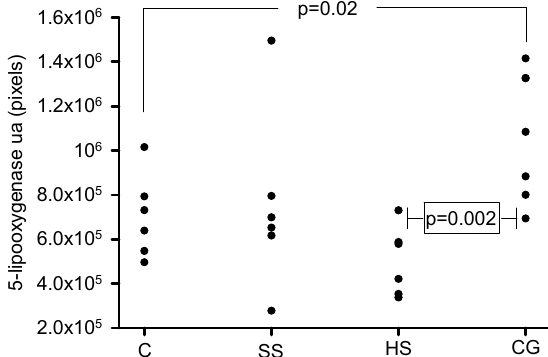
Figure 11. Densitometric analysis for the marker 5-LOX in the glomeruli from the experimental groups. The 5-LOX antibody was negative for the C, SS and HS vs. CG groups. Abbreviations: C = control, SS = saline solution, HS = healthy subjects and CG = collapsing glomerulopathy ( n = 6). Each point is the mean of the analysis of 5 glomeruli per group.